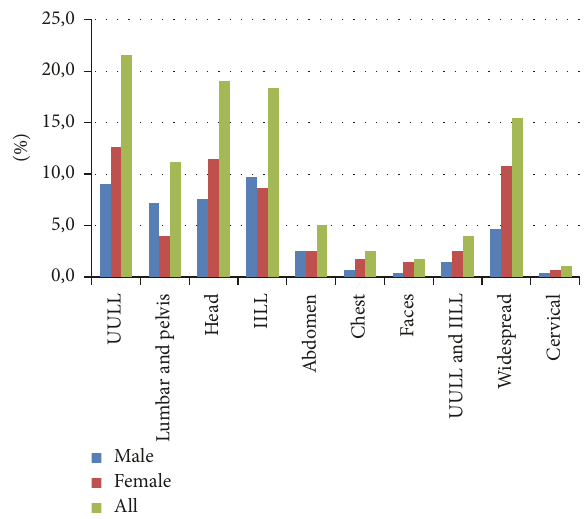
Figure3:Locationofpainreportedbyfemaleandmaleparticipants. In Brazil in 2015-2016. UULL: upper limbs and IILL: lower